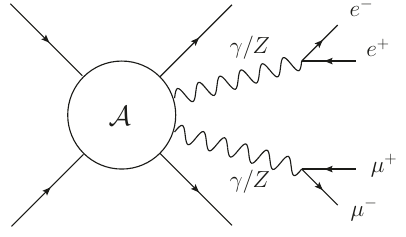
Figure 2 . (cid:13)=Z resonant diagrams in pp